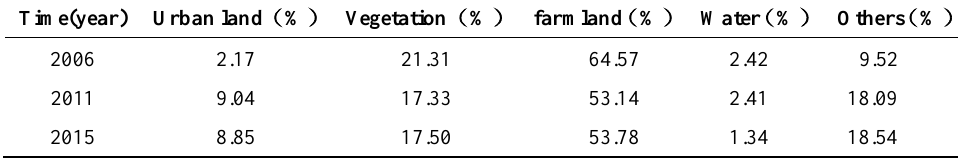
Table 1. Results of land use classification in different